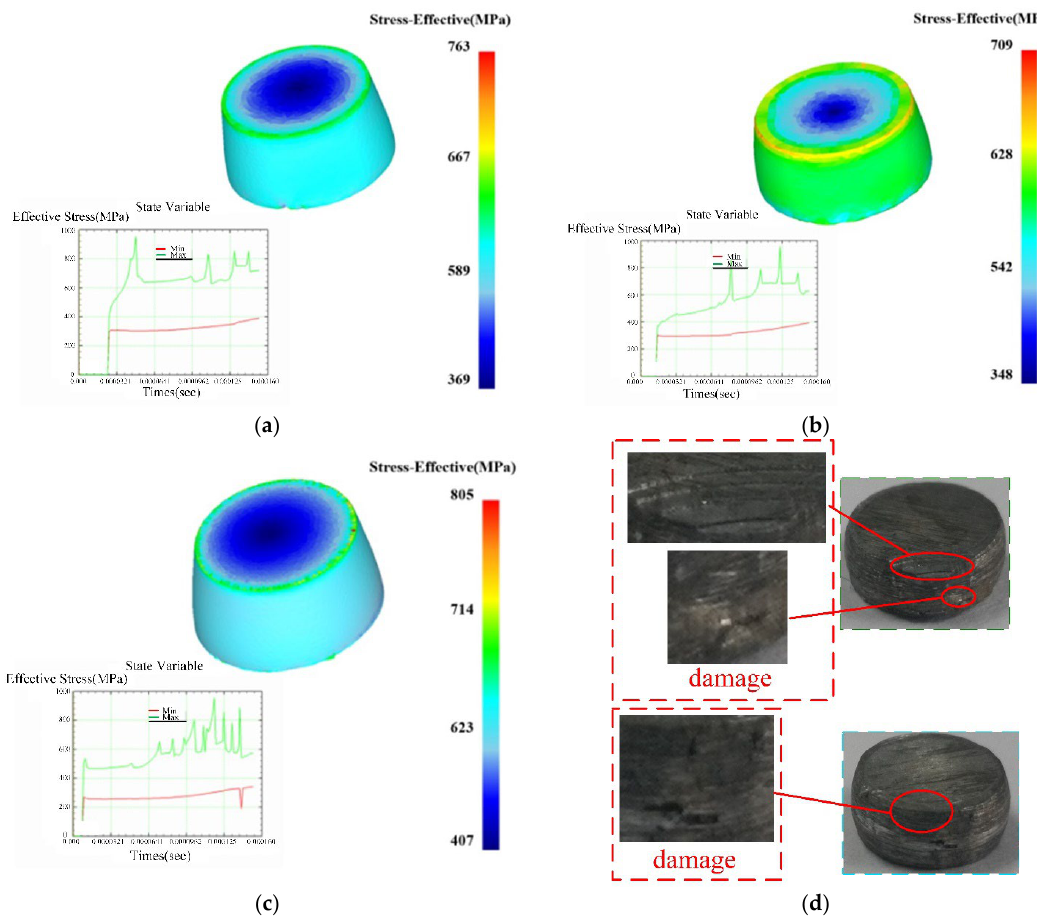
Figure 13. Comparison of simulated equivalent stress nephogram and damage forms of workpieces: ( a ) ε = 0.2, RD -30°- TD ; ( b ) ε = 0.2, RD -45°- TD ; ( c ) ε = 0.2, RD -60°- TD ; ( d ) comparison diagram of a ) ε = 0.2, RD-30 ◦ -TD; ( b ) ε = 0.2, RD-45 ◦ -TD; ( c ) ε = 0.2, RD-60 ◦ -TD; ( d ) comparison diagram of sample damage. ( sample